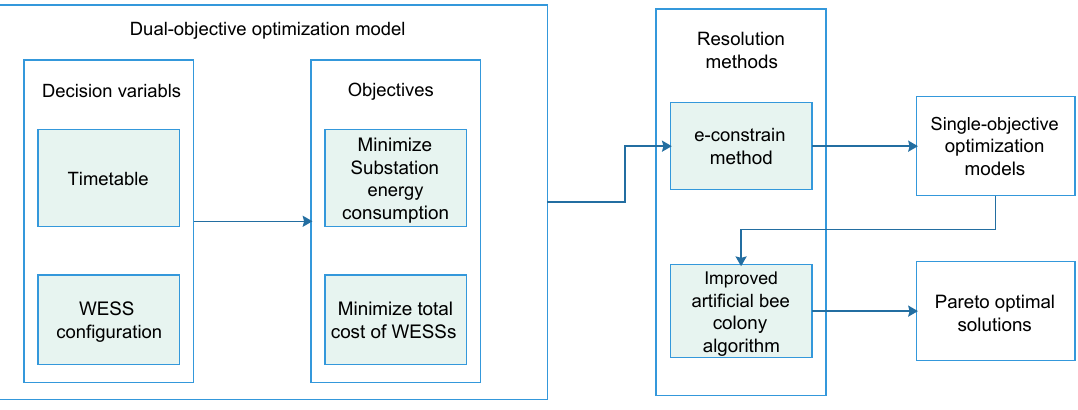
Figure 1. Main ideas of this